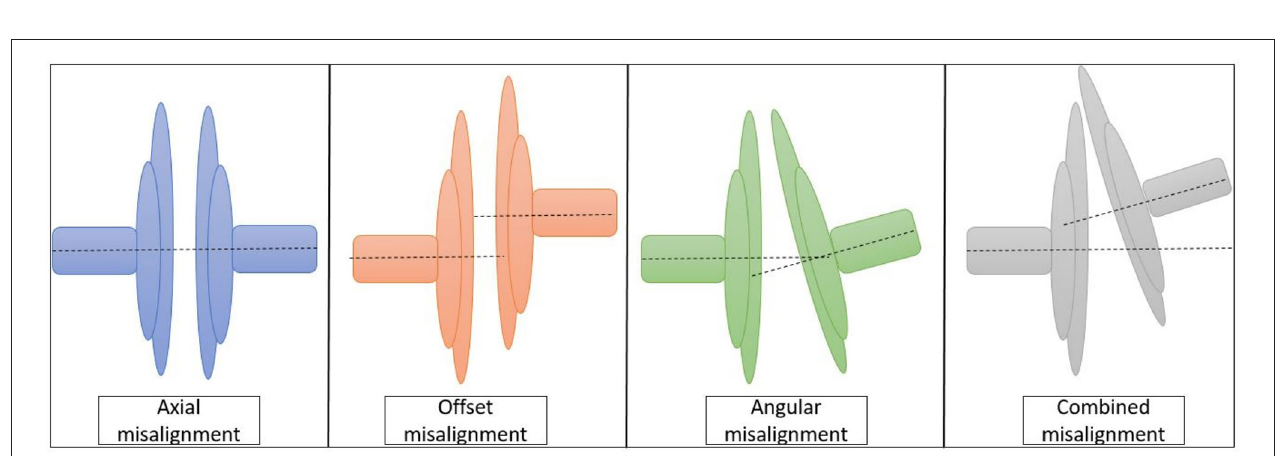
FIGURE 5 | Types of shaft misalignment adapted from Khan et al.